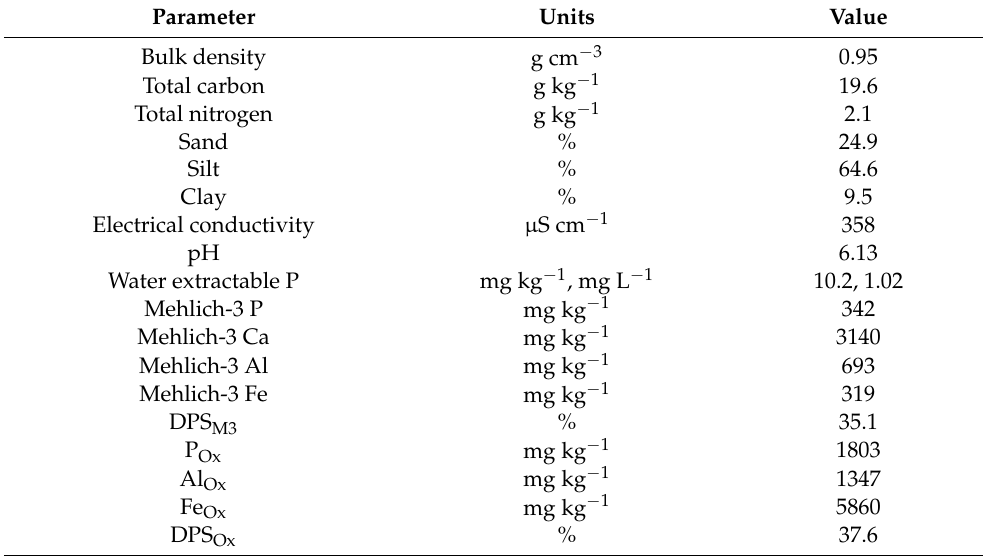
Table 1. Characterization of the Blount soil used in flow-through and batch experiments. DPS M3 and DPS Ox : degree of phosphorus (P) saturation based on molar ratio of Mehlich-3 and ammonium oxalate extractable P: Al + Fe. Parameter Units Value Bulk density g cm − 3 0.95 Total